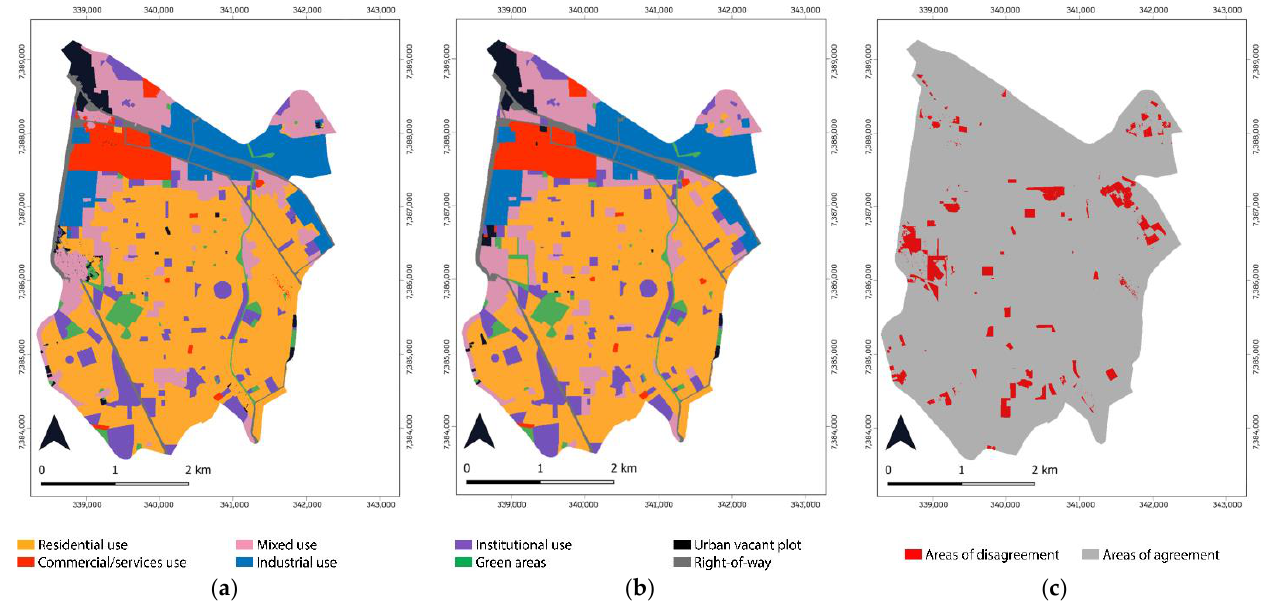
Figure 13. ( a ) 2018 simulated land use map with refined calibration, ( b ) 2018 real land use map, ( c ) areas of agreement and disagreement. ( c ) areas of agreement and disagreement.